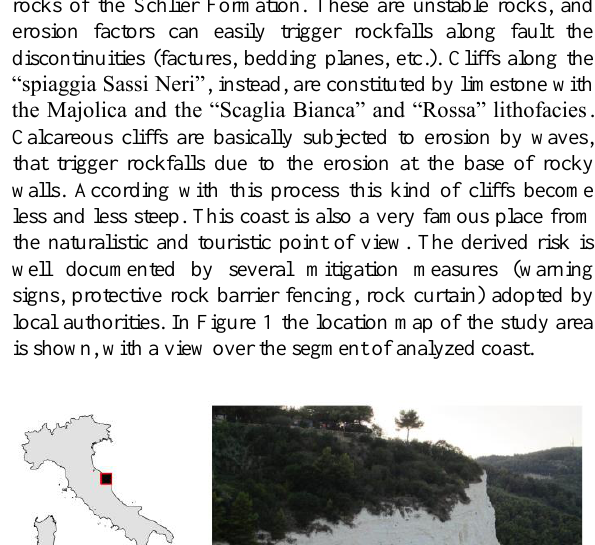
Figure 2a and 2b display a warning sign, and protective rock